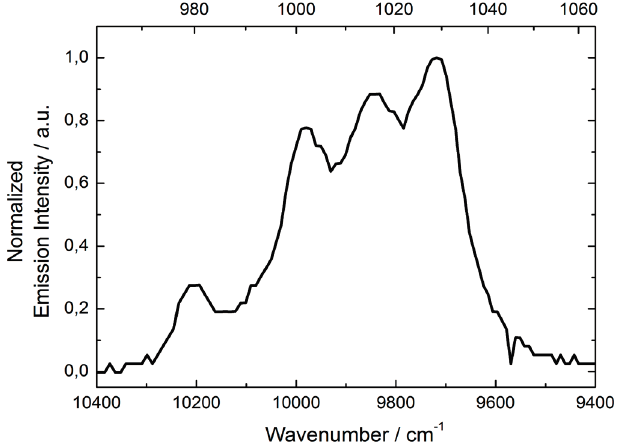
Figure 6. Luminescence spectrum of 2 in the Near Infrared (NIR) range for λ ex = 22,222 cm − 1 (450 nm) in solid-state at 77